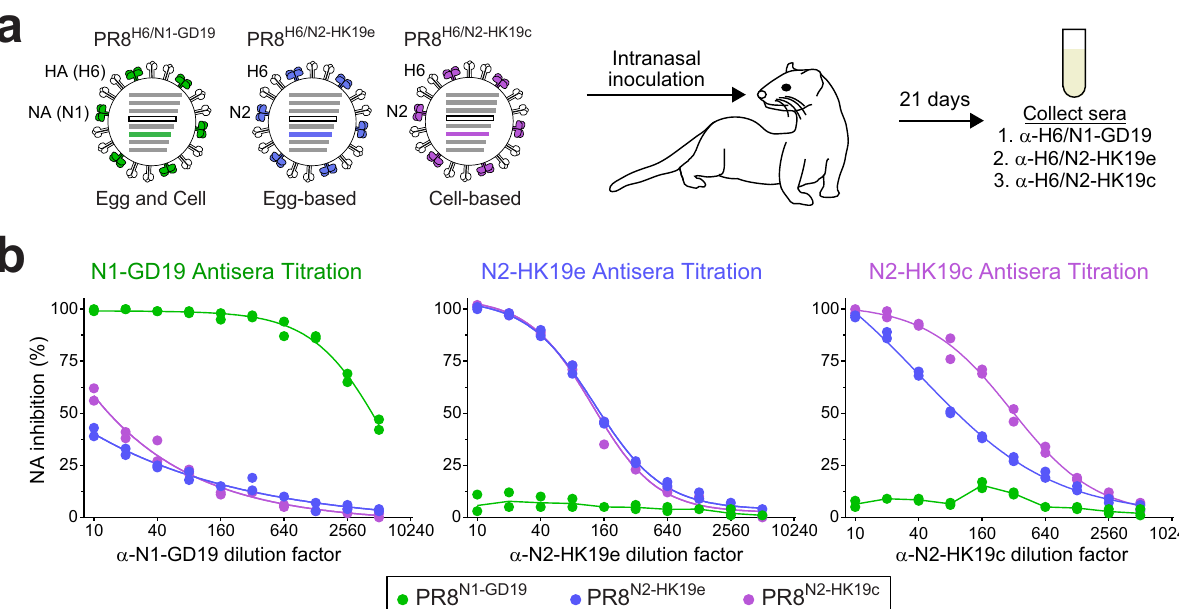
Fig. 3 Characterisation of ferret antisera against the NAs in the 2020 – 2021 IAV vaccine strains. a Diagram for generating ferret antisera against the NA antigens (N1-GD19, N2-HK19e, and N2-HK19c) from the recommended egg and cell-based IAV vaccine strains for the 2020 – 21 northern hemisphere season. Ferret sera were collected 21 days post intranasal inoculation with PR8 double gene reassortant viruses carrying H6 and one of the vaccine strain NAs. b Speci fi city and reactivity of each ferret antiserum was assessed by the ELLA using PR8 single gene reassortant viruses that carry the IAV vaccine strain NAs. Representative data from a single analysis performed in duplicate are displayed. Source data are provided in the source data fi